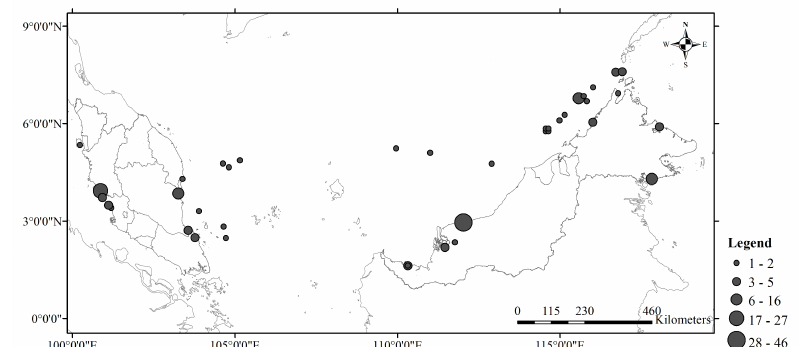
Figure 1. Map of the selected elasmobranch sampling sites in